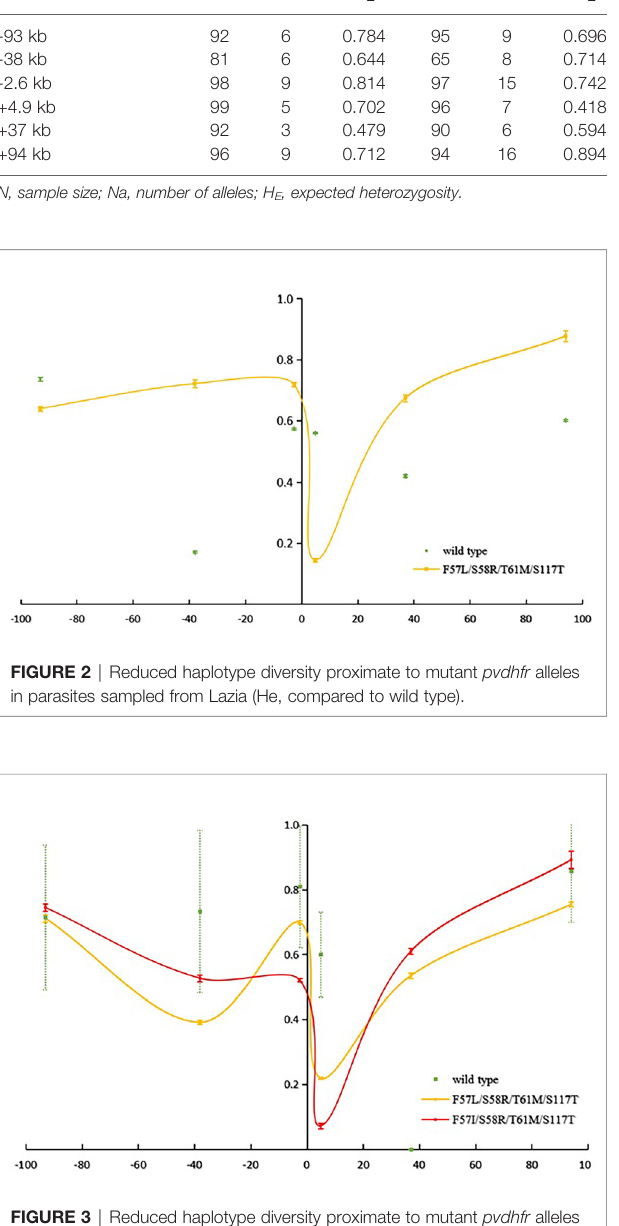
FIGURE 3 | Reduced haplotype diversity proximate to mutant pvdhfr alleles in parasites sample from Myitsone (He, compared to wild type).